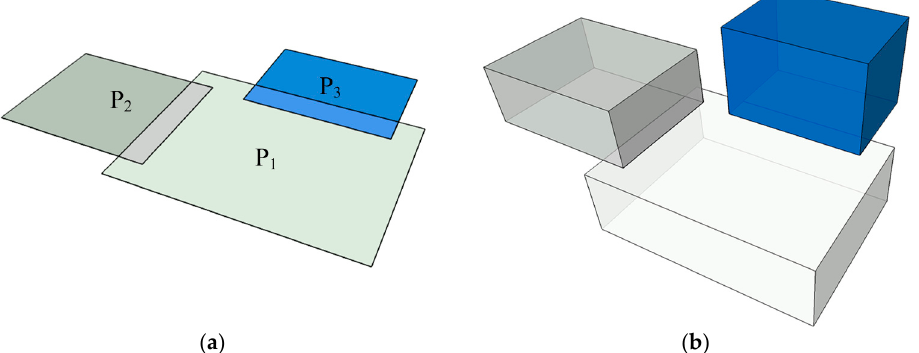
Figure 1. ( a ) Three overlapping 2D parcels in 3D space; and ( b ) 3D parcels generated by extruding 2D parcels in ( a ).